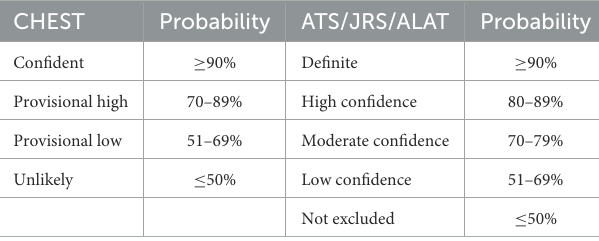
TABLE 1 Diagnostic confidence categories in the CHEST and the ATS/JRS/ALAT guidelines (7, 8).